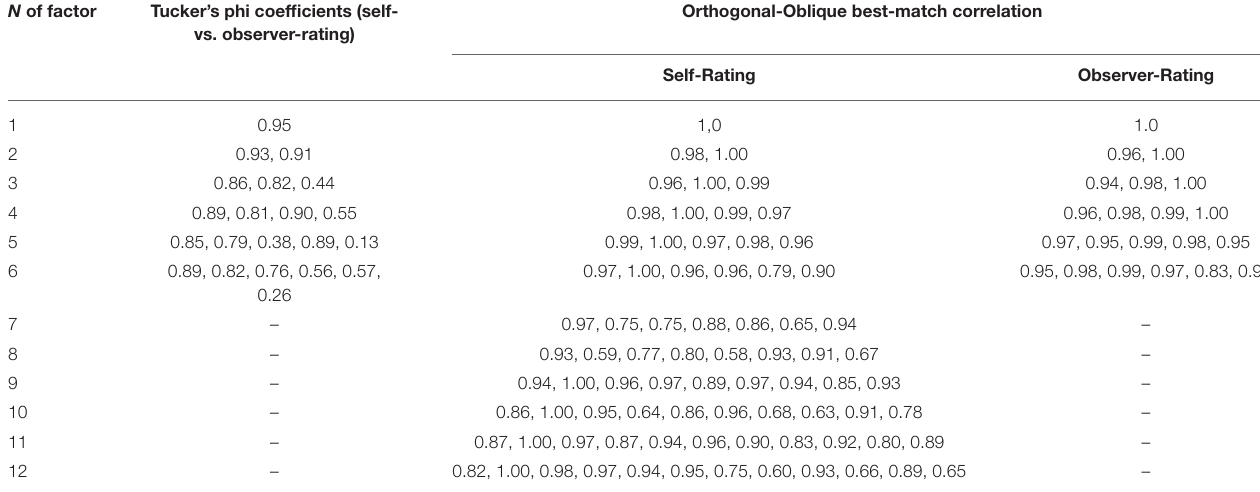
Orthogonal-Oblique best-match